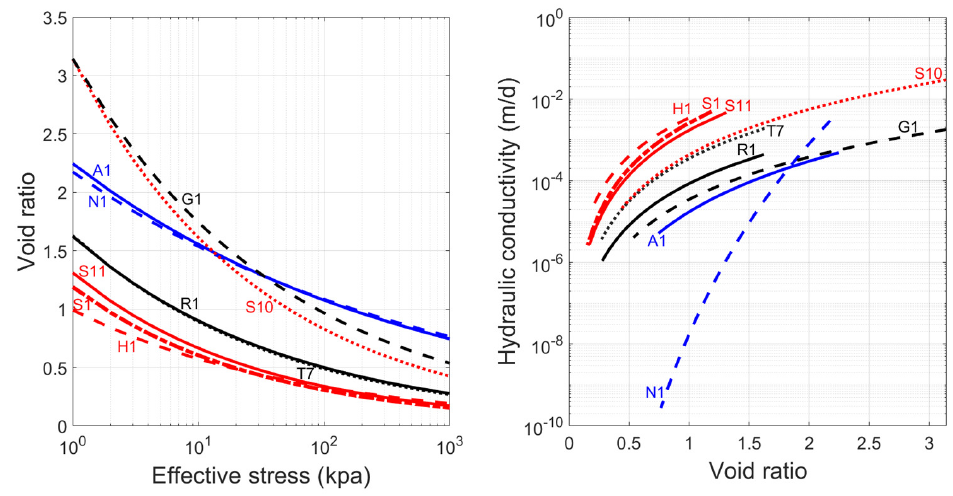
Figure 11. Effective stress, void ratio and hydraulic conductivity for tailings material experiments.